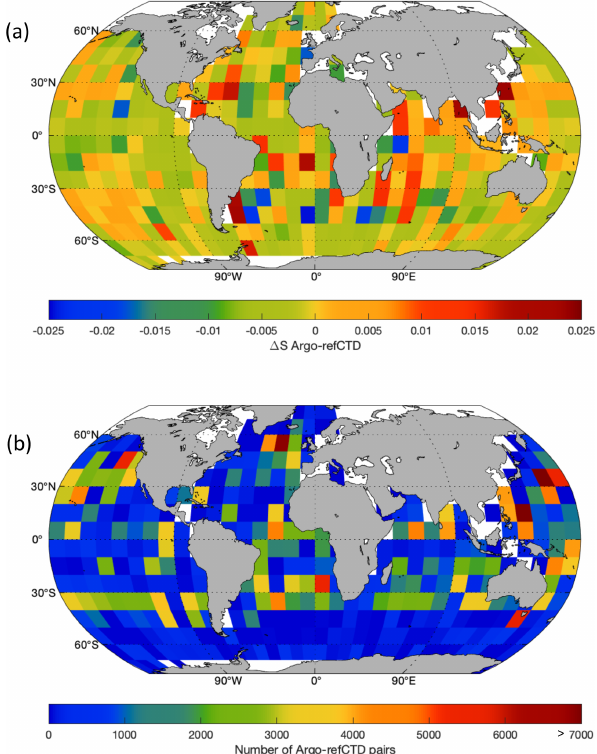
Figure 6. (a) Spatial distribution of (cid:49)S Argo-refCTD , averaged in 10 ◦ × 10 ◦ grid squares, and (b) number of Argo-refCTD pairs in each 10 ◦ × 10 ◦ grid square. The Argo data used in this analy- sis are delayed-mode salinity data from PSAL_ADJUSTED, with PSAL_ADJUSTED_QC = “1” and DATA_MODE = “D”, as of April 2022. Note that this analysis only accounts for about 20% of the Argo delayed-mode salinity data. White color denotes areas with no Argo data or no Argo-refCTD match at the time of this